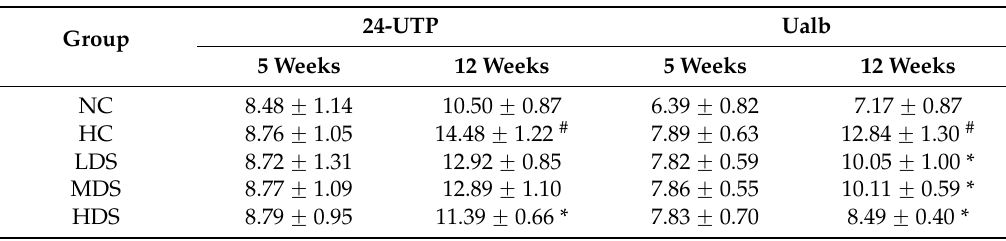
Table 2. 24 h-UTP and Ualb levels in rats from different groups after high-fat diet (5 weeks) and sesamin treatment (12 weeks). 24-UTP Group